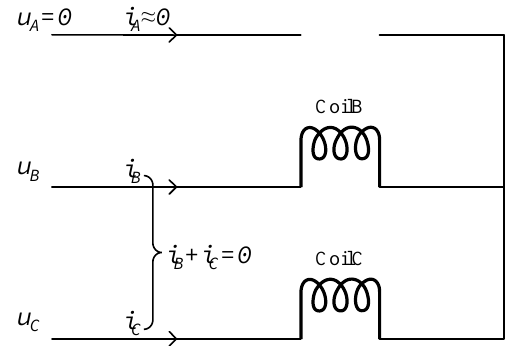
≈ 0 and 𝑖 + 𝑖 = 0 . 𝐴 𝐵 𝐶